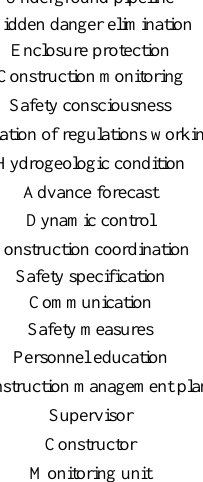
Figure 4. Cluster analysis results of safety risk factors and participants.